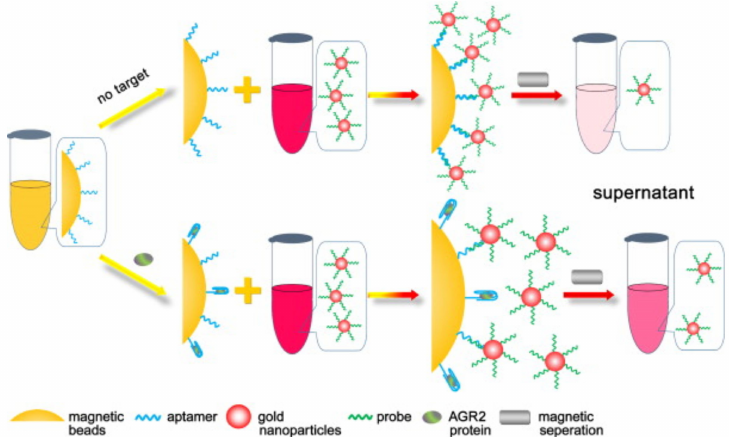
Figure 5. Schematic representation of AGR2 protein detection procedure. Reprinted from [75] with permission of Elsevier provided by Copyright Clearance